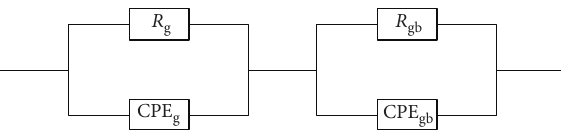
F 6: Equivalent circuit model of the